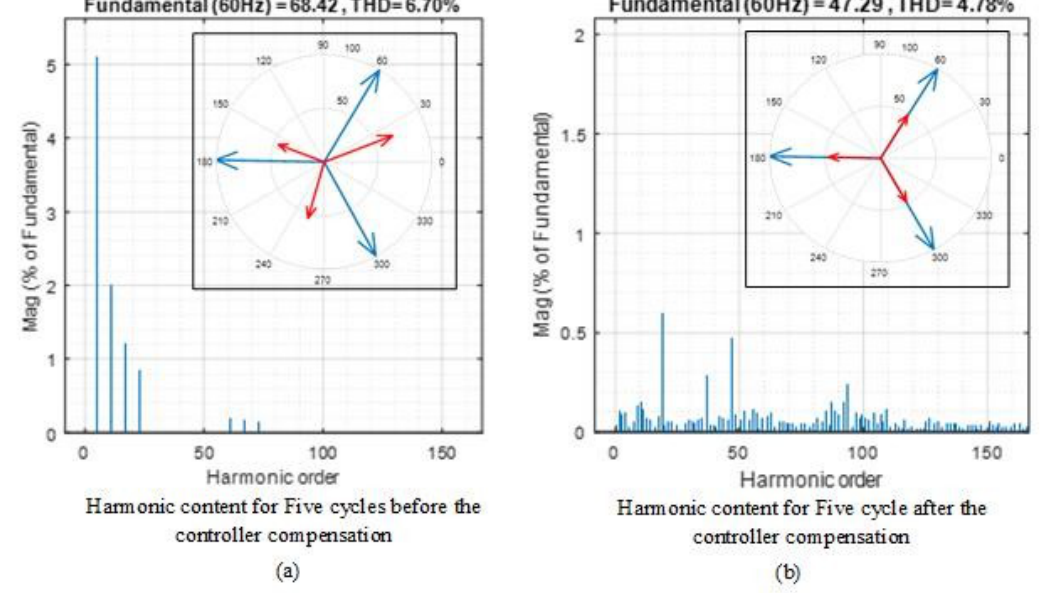
Figure 6. Phasor Diagram for the voltage and current at PCC ( a ) before the proposed technique and ( b ) after the proposed technique.